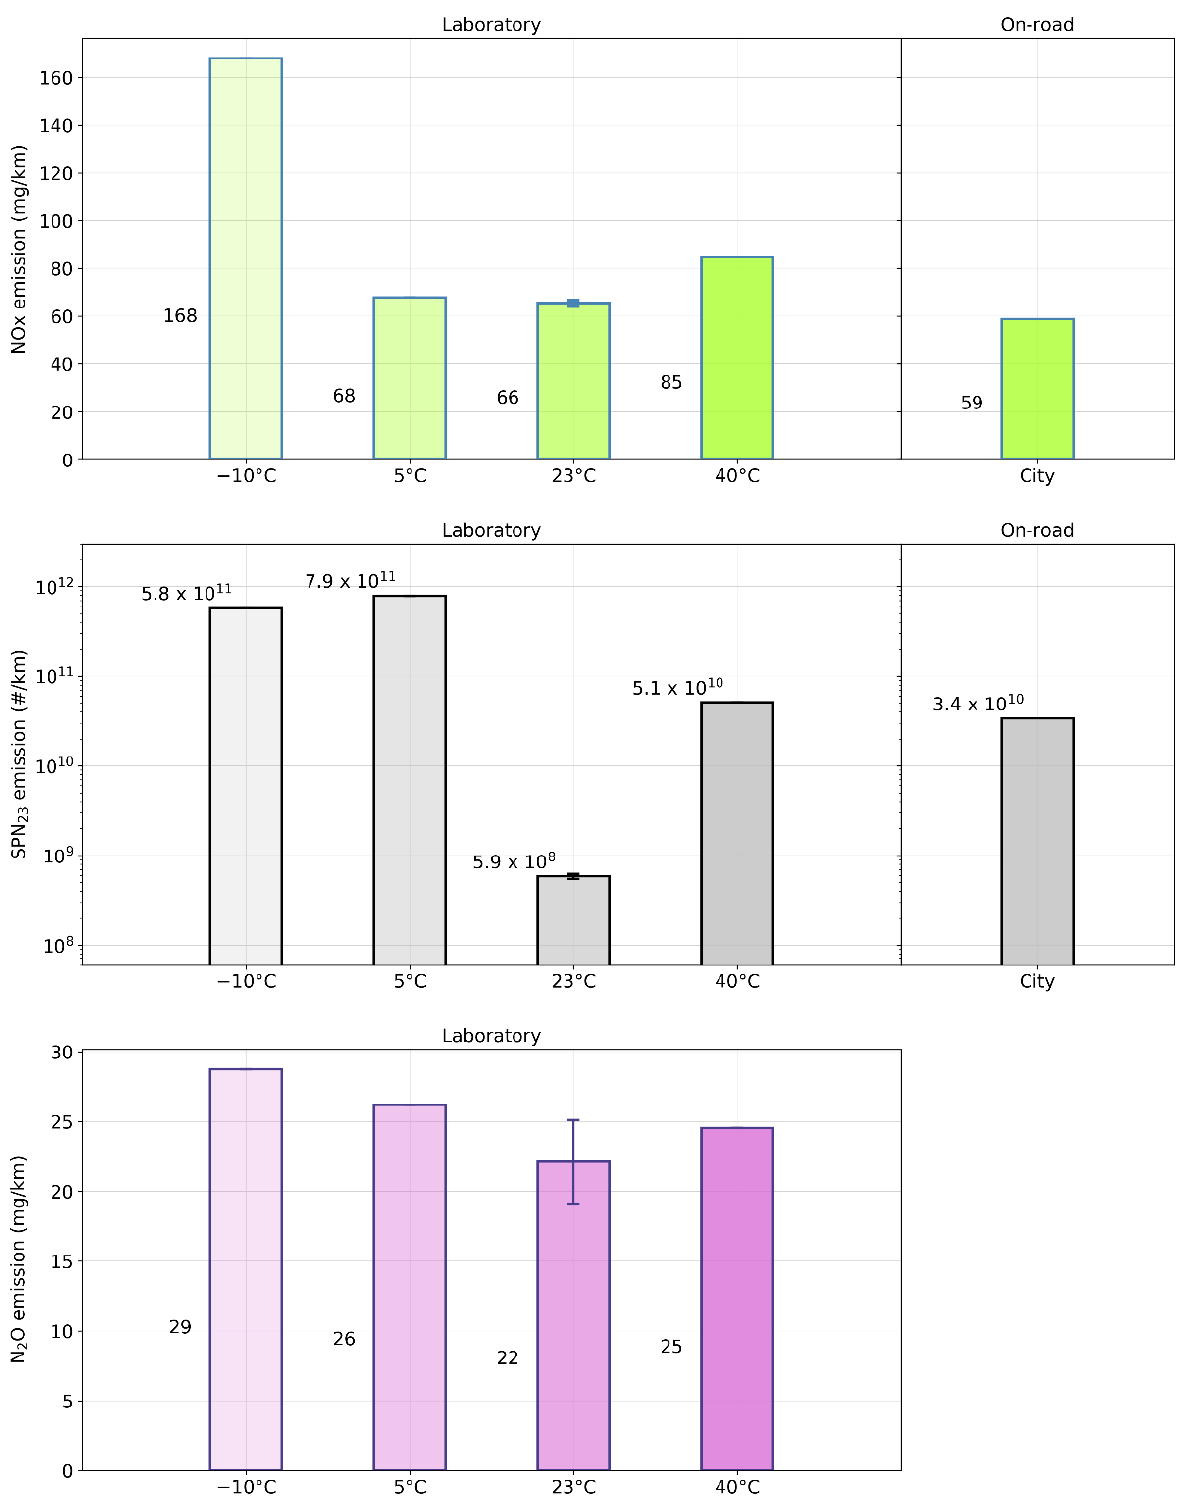
Figure 7. Emissions of regulated pollutants and N 2 O on: (left panels) TfL tests as a function of temperature; (right panels) City route (when available). All the tests were performed with the minimum SOC and with the default user selectable mode of operation. Error bars on the graph represent maximum and minimum values for conditions having more than one test. See Methods section for additional details.